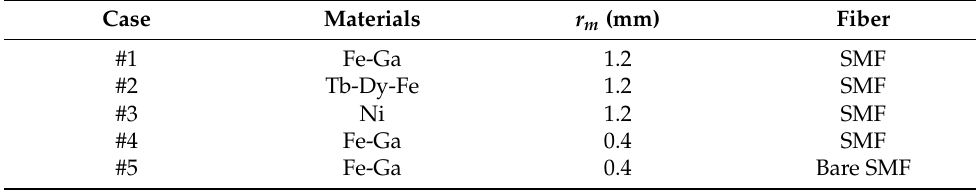
Table 1. Parameters of the sample.